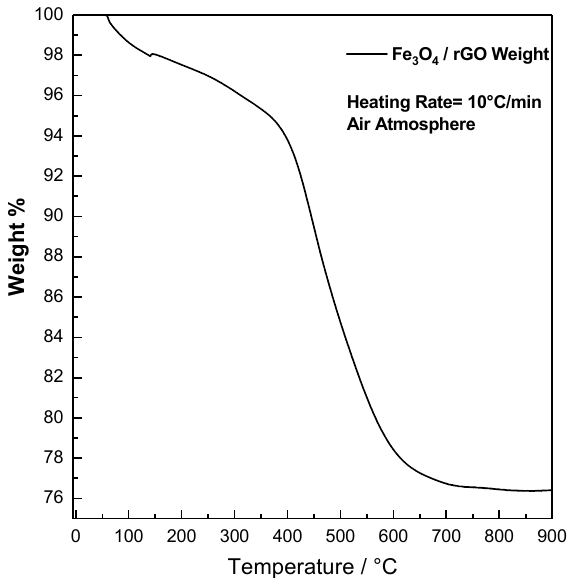
Figure 3. Thermogravimetric characterization of Fe 3 O 4 /rGO at 10°/min in air atmosphere.